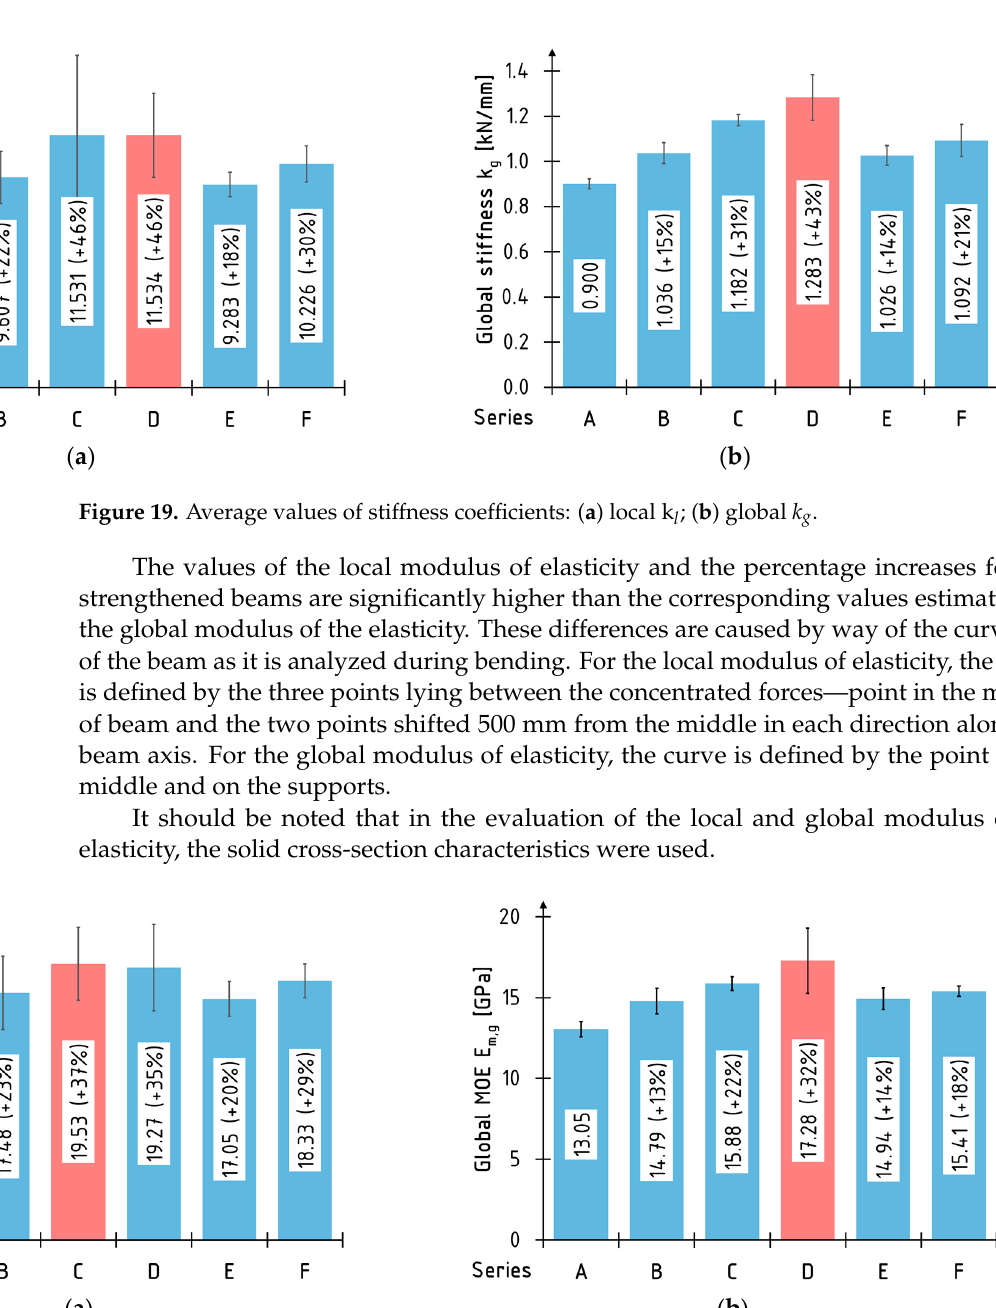
Figure 20. Average values of modulus of elasticity: ( a ) local E m,l ; ( b ) global E m,g .